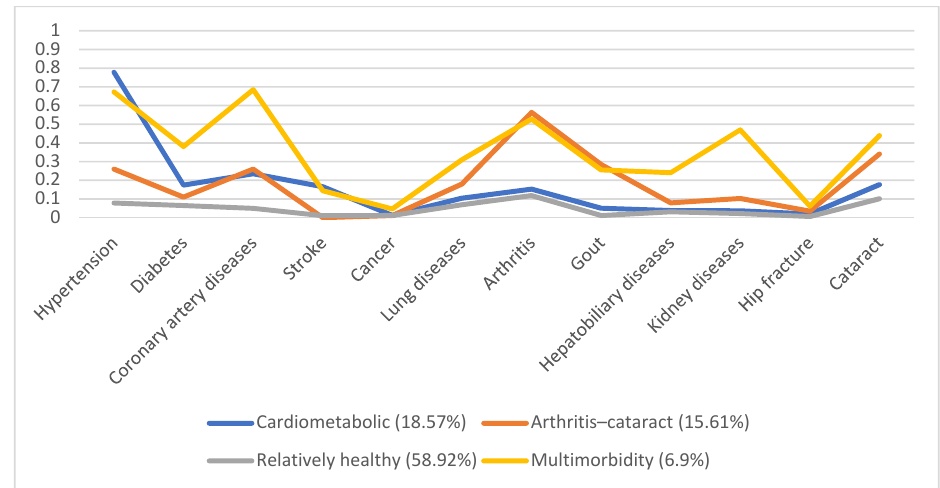
Figure 1. Multimorbidity patterns in 1996.